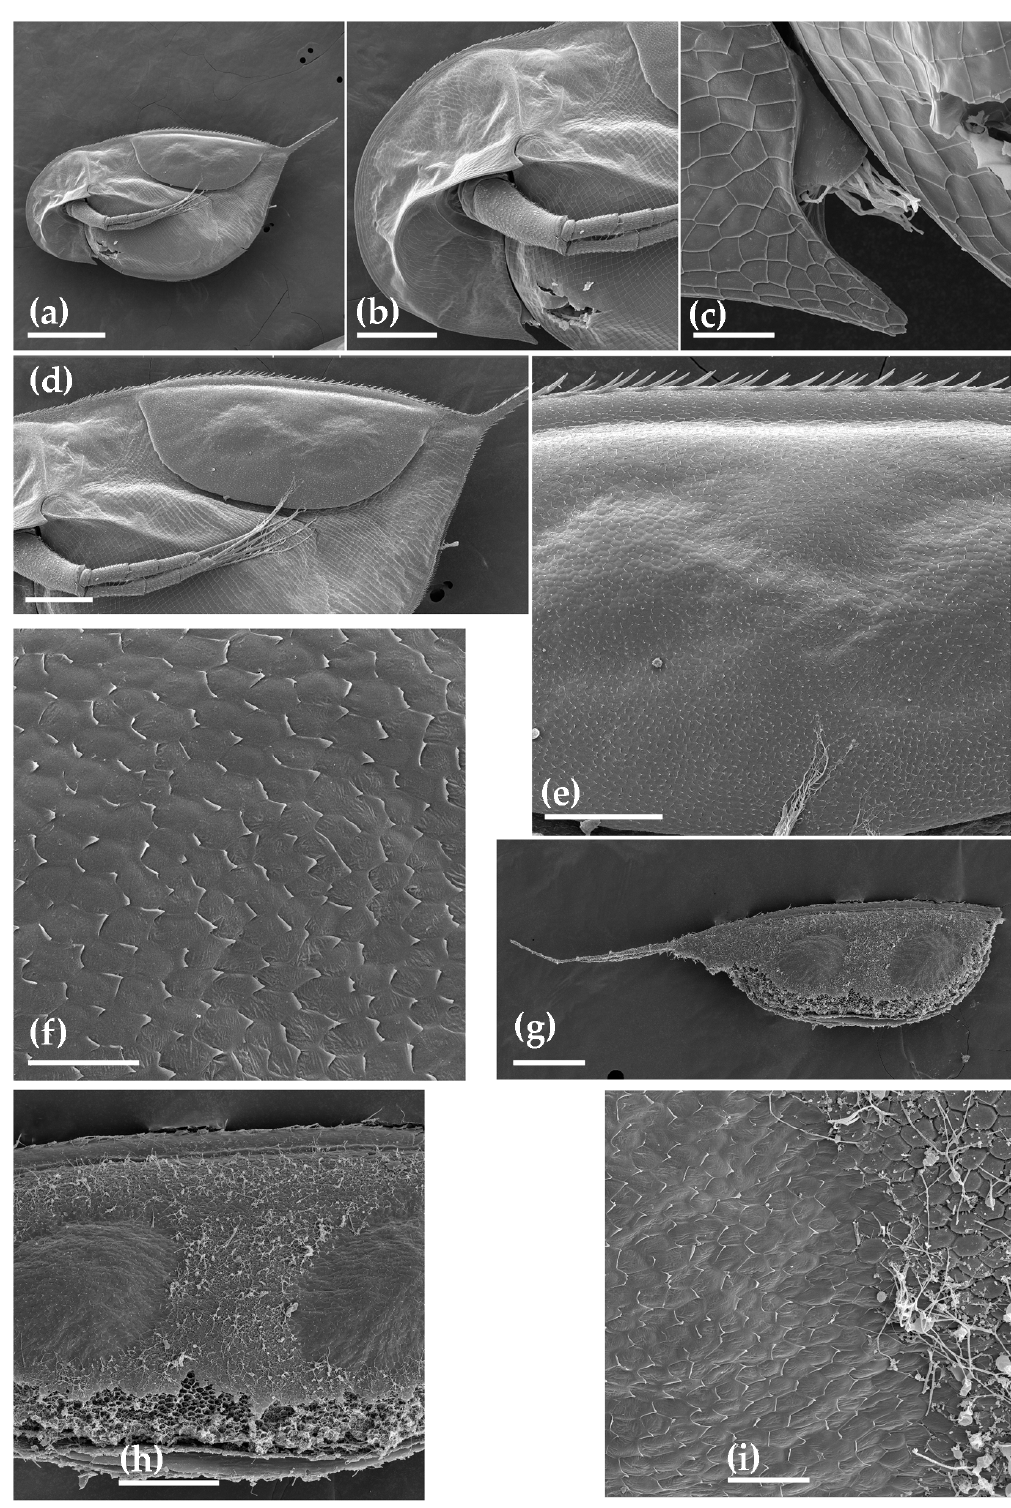
Figure 8. Daphnia arabica sp. nov., an ephippial female ( a – f ) and a dumped ephippium ( g – i ) from Al Shuwaib Dam, near Al Ain city, United Arab Emirates (material from the laboratory culture). ( a ) Ephippial female, lateral view. ( b ) Head. ( c ) Rostrum. ( d ) Ephippium. ( e ) Ephippium with resting eggs. ( f ) Ornamentation of central portion of ephippium on higher magnification. ( g ) Dumped ephippium. ( h ) Ephippium with resting eggs. ( i ) Ornamentation of central portion of ephippium. Scale bars are 0.5 mm for ( a ); 0.2 mm for ( b , d , g ); 0.1 mm for ( e , h ); 0.02 mm for ( c , f , i ).